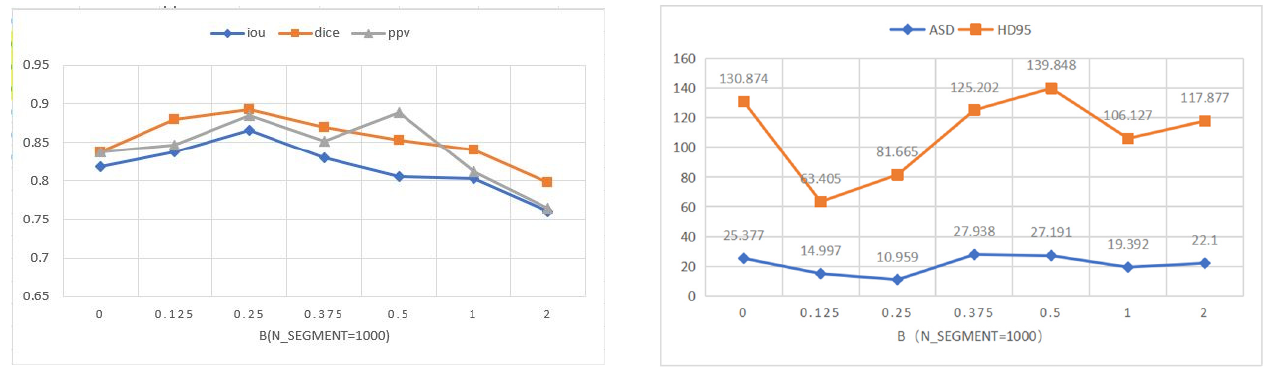
Figure 6. Performances of our method with different values of β on PH2 dataset.Set the horizontal axis to Log Scale.